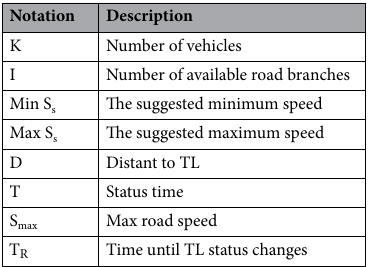
Table 2. Notations of algorithm 1 and their